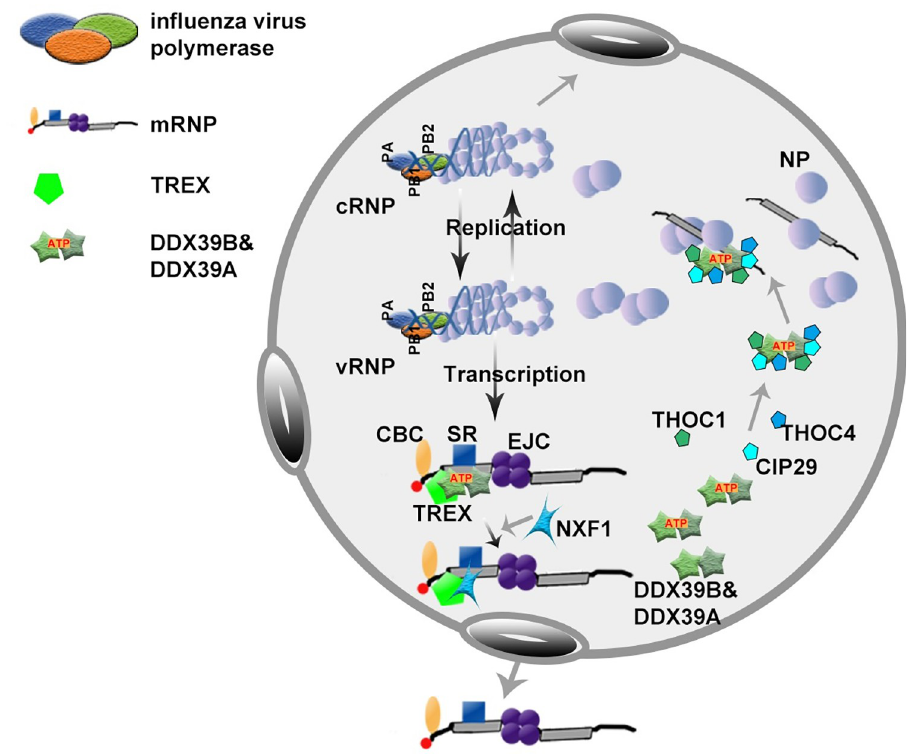
Fig 8. Schematic model of TREX (transcription/export)-NP complex involved in replication and transcription of influenza A virus. The TREX complex subunits, THOC1, THOC4 and CIP29, were recruited to DDX39B-DDX39A-NP complex in an ATP-dependent manner via the interaction with DDX39B or DDX39A. However, excess TREX-NP complexes interfere with the normal oligomerization state of NP depending on the ratio between the viral and host proteins. Interestingly, NP protein, but not NS1, reversed such inhibitory effects. On the other hand, DDX39B and DDX39A cooperated with subunits of the TREX complex to participate in nuclear and cytoplasmic transport of viral